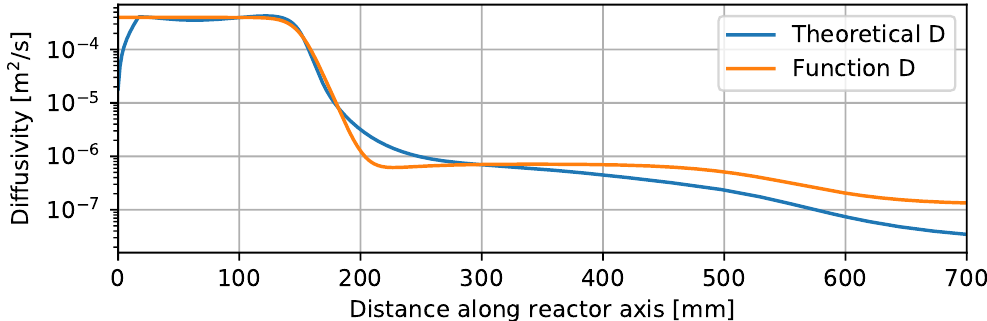
Figure 13. Comparison of the theoretical, diameter based, particle diffusivity (blue), and the analytically approximated particle diffusivity with a function (orange). Both lines are for a flowrate of 0.5lmin − 1 , temperature of 1250 ◦ C and ferrocene mass fraction of